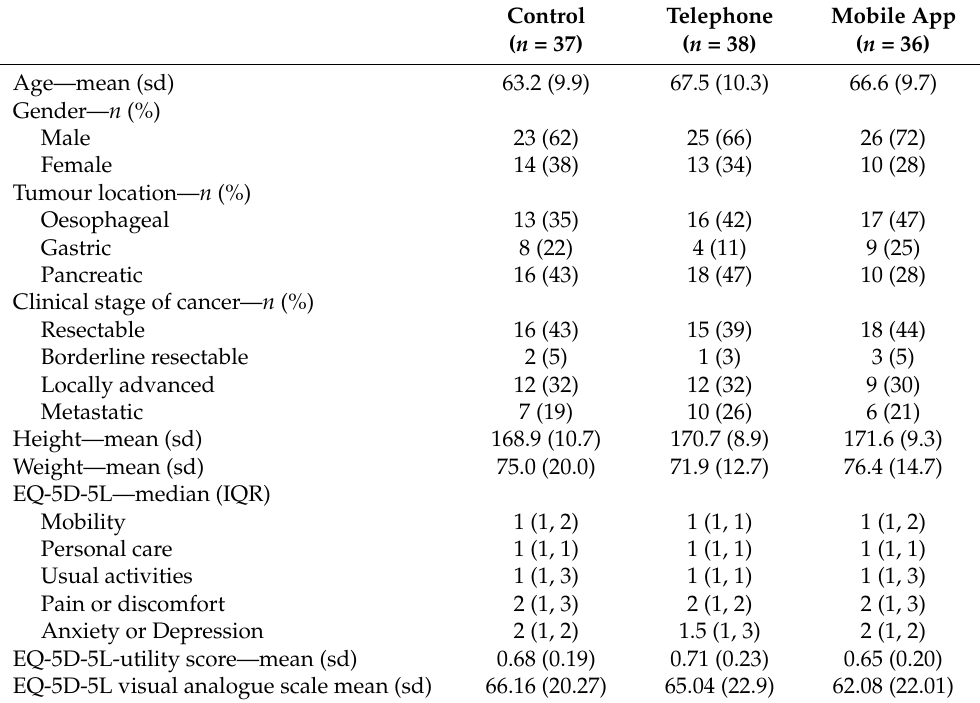
Table 1. Participant demographics at